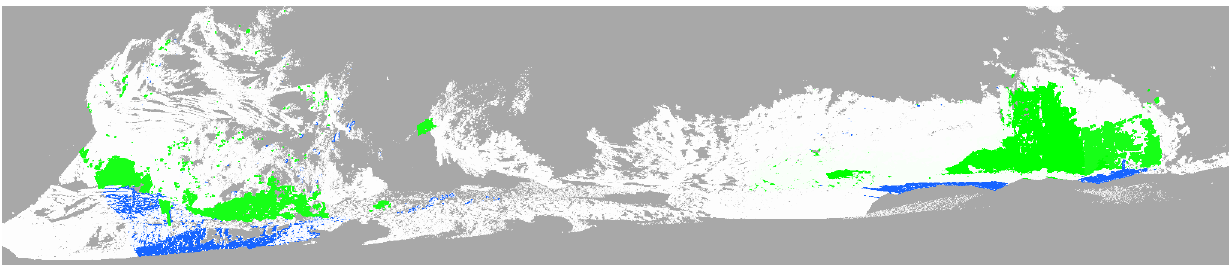
Figure 7: Deposition and erosion as detected using the proposed